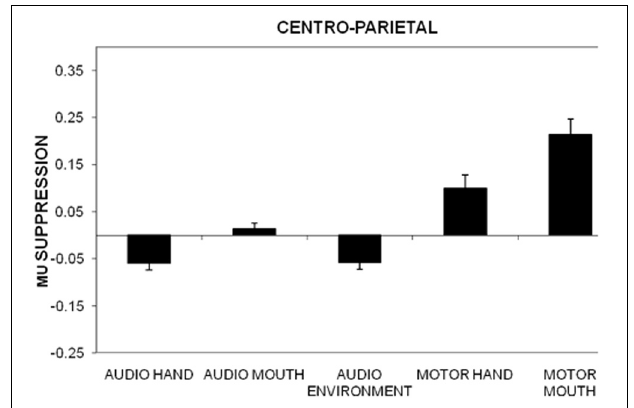
FIGURE 1 | Mu suppression over centro-parietal regions (C3, C4, P3, P4) in the action (hand, mouth) and non-action (environmental) auditory conditions as well as during the motor actions (hand, mouth). Mu suppression is determined as the log of the ratio between experimental condition and baseline condition. Error bars are standard error of the mean.